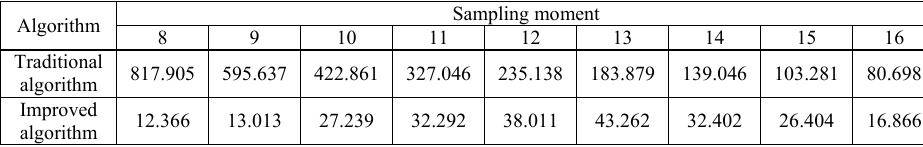
Table 1. Target trajectory filter values